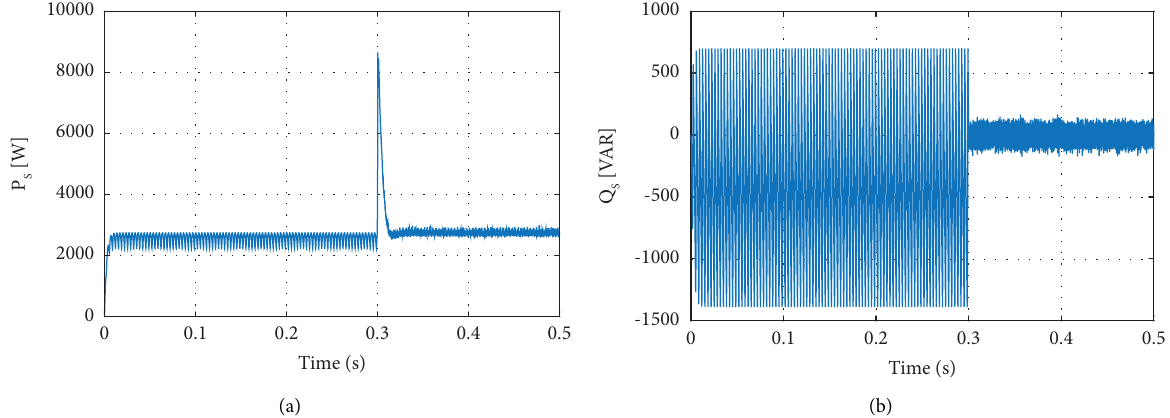
Figure 14: FIL experimental results: (a) reactive and (b) active powers. Fundamental (50 Hz) = 18.33, THD= 3.26%